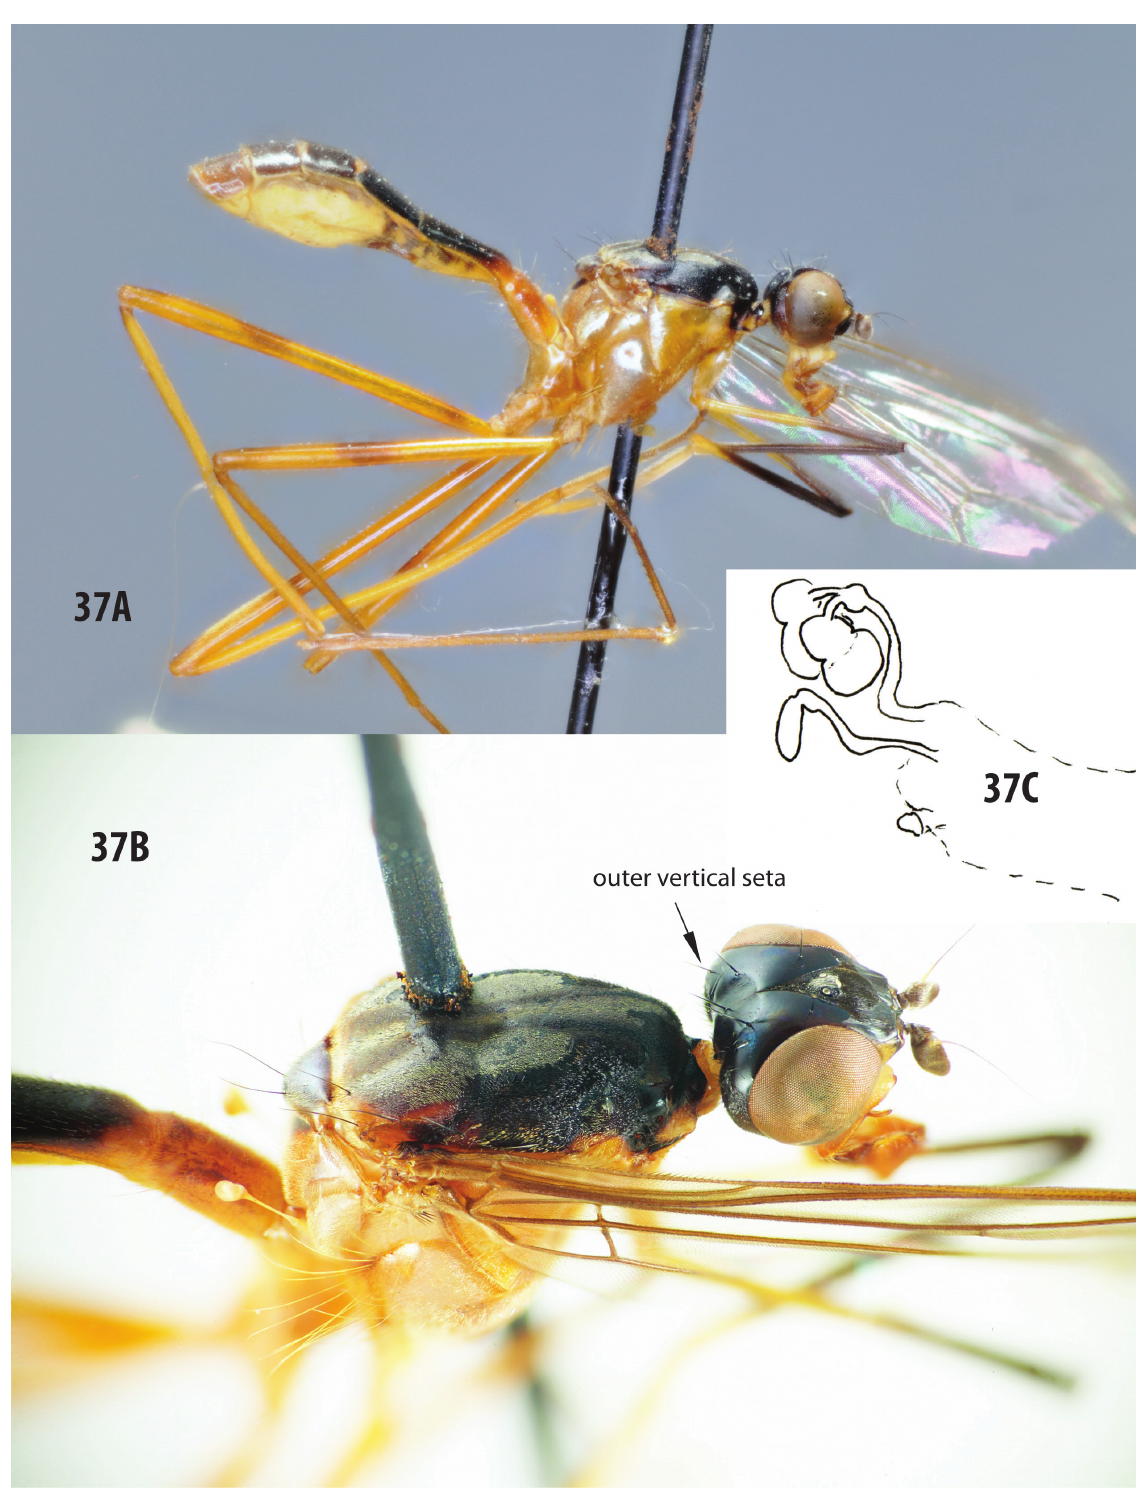
Fig. 37. Mesoconius woytkowskii sp. nov., holotype, ♀, CNCI. A–B . Lateral and dorsolateral views. C . Sketch of spermathecae and associated structures, showing separate origins of single and double spermathecal ducts (based on illustration in Albuquerque